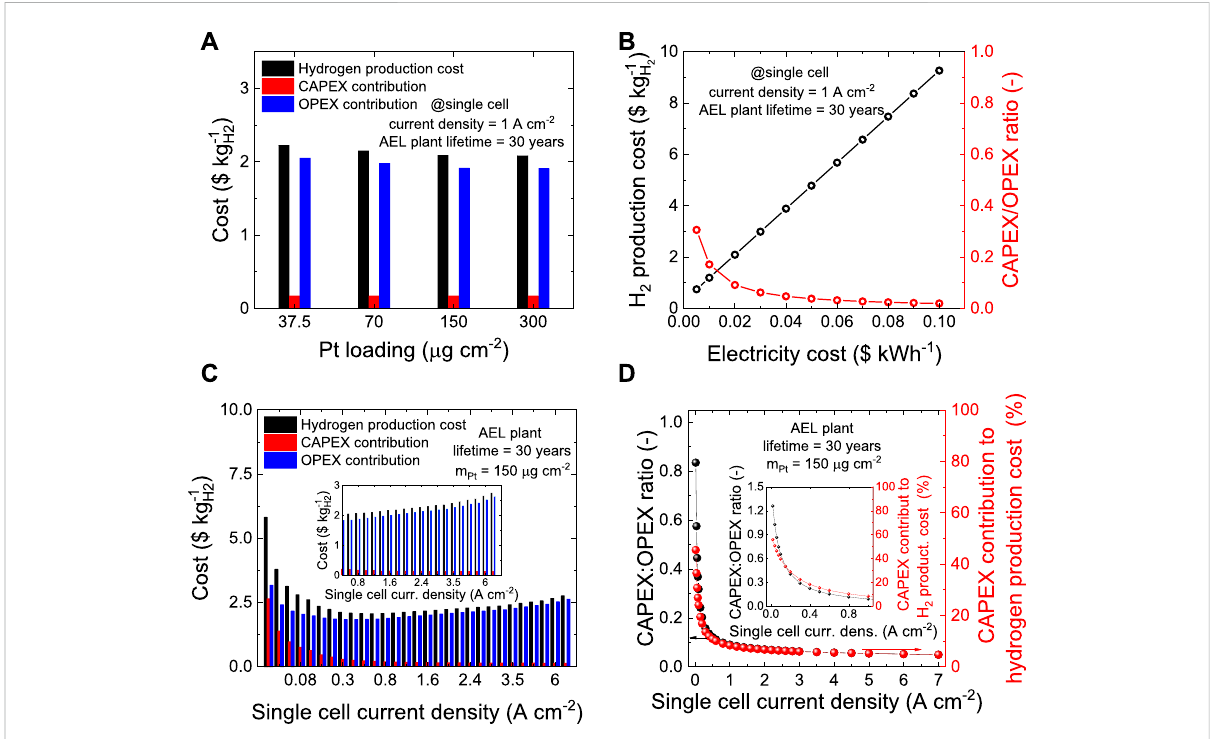
FIGURE 6 (A) OPEX, CAPEX and overall hydrogen production cost for ideal 1 MW-scale AEL plants based on the Pt/C cathodes with different m Pt (single cell current density = 1 A cm − 2 ; AEL plant lifetime = 30 years). (B) Hydrogen production cost and CAPEX/OPEX ratio for the 1 MW-scale AEL plant based on the Pt/C cathodes with m Pt = 150 μ g cm − 2 , as a function of the electricity cost (single cell current density = 1 A cm − 2 , AEL plant lifetime = 30years). (C) OPEX,CAPEXandoverallhydrogenproductionfor1